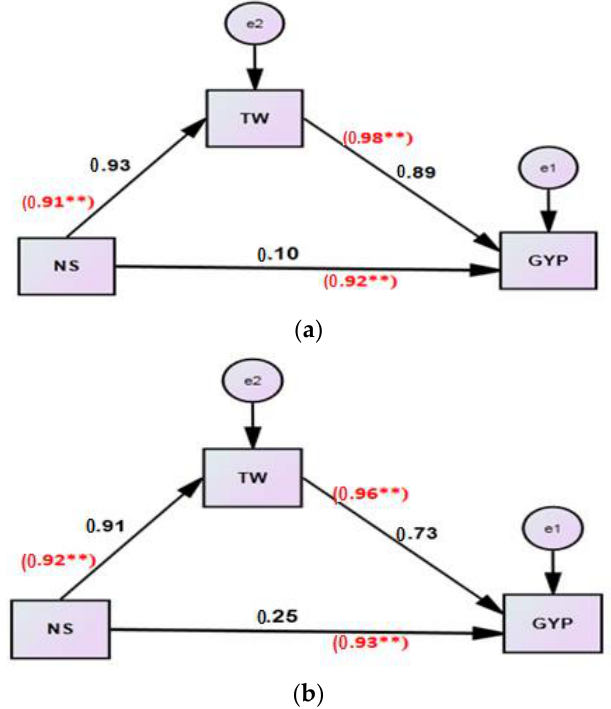
Figure 1. ( a ) The path analysis for direct and indirect effects and Person correlation (r) of (NS) as independent variable and (TW) as mediator variable and (GYP) as dependent variable of first season. ( b ) The path analysis for direct and indirect effects and Person correlation (r) of (NS) as independent variable and (TW) as mediator variable and (GYP) as dependent variable of second season (** indicates the different significance at p < 0.01 level). Table 5. Direct, indirect, total effects, type of mediation and confidence interval by bootstrapping of Tw and NS traits on grain yield per plant over all five populations of two crosses of